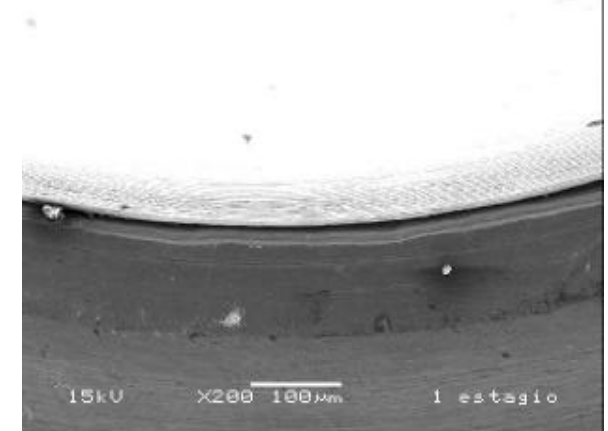
FIGURA 8- Localização da fenda no sistema de dois estágios (seta). Observar a presença de único plano (x50)